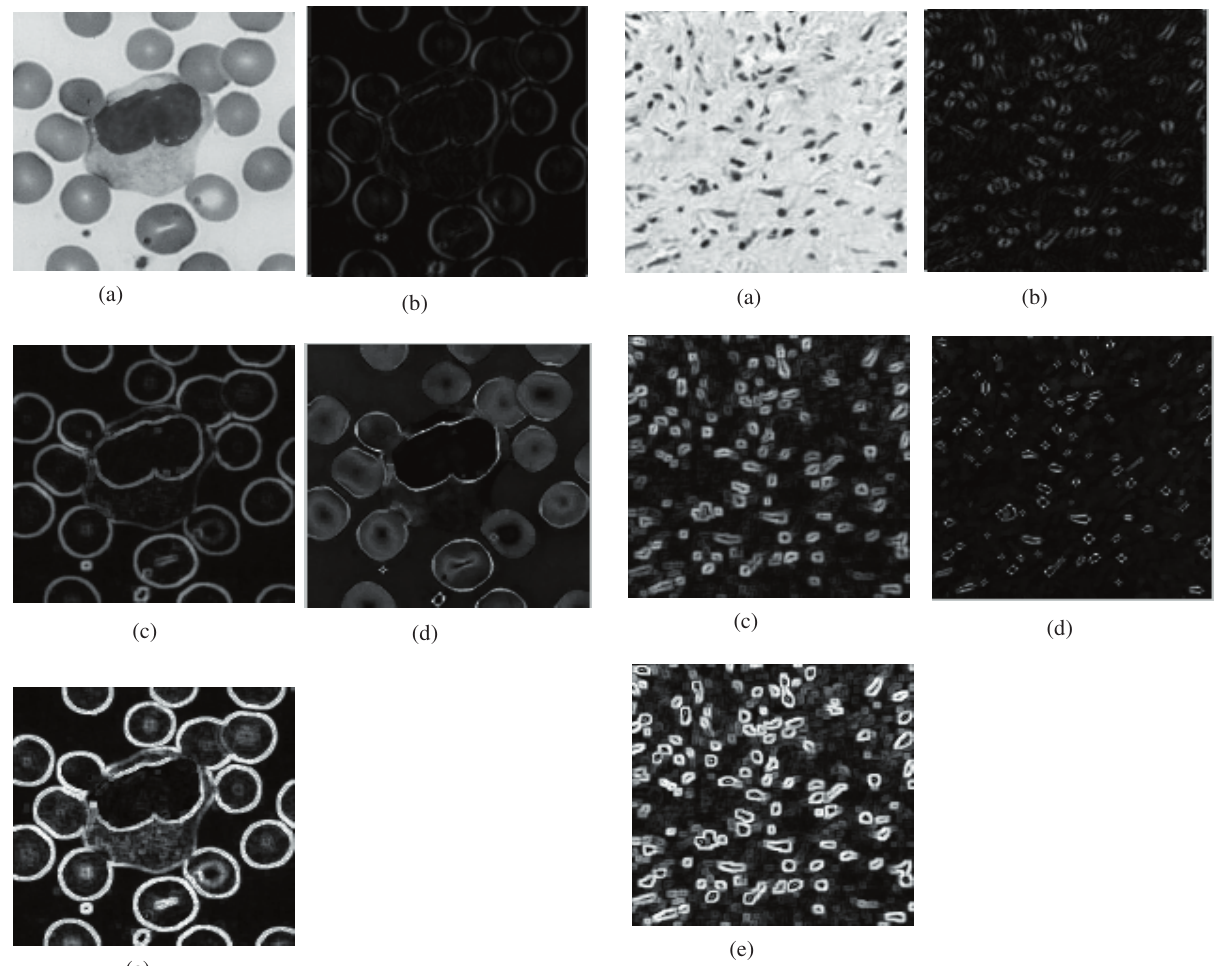
Fig. 9 : a) nuclei image, b) edge image using fuzzy morphology, c) edge image using the interval valued fuzzy set, d) edge image Fig. 8 : a) blood cell image, b) edge image using